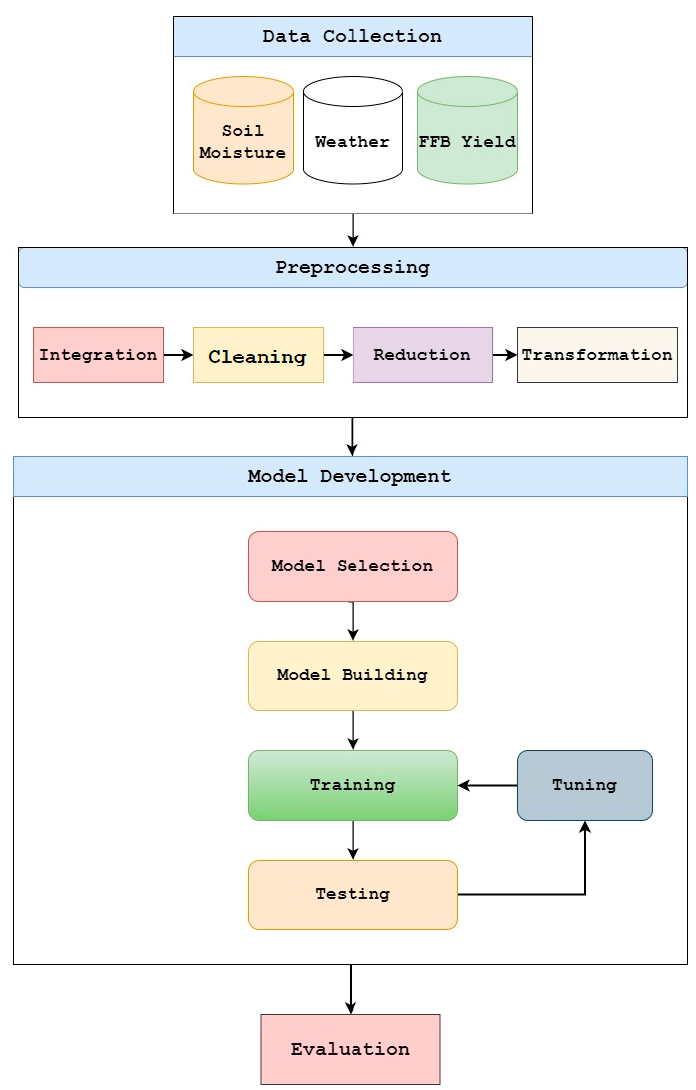
Figure 2. Proposed workflow.